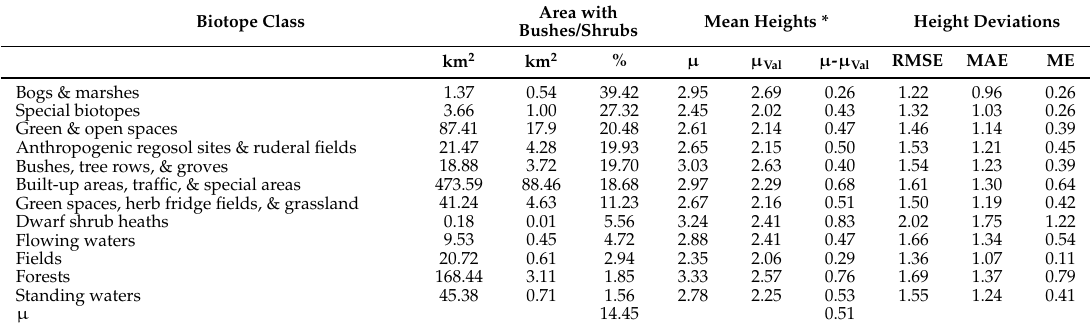
* The mean heights are weighted with the fractions of each biotope class layer on the pixels of the respective CHMs. Table 5. Area with bushes/shrubs (km 2 , %), Weighted mean vegetation heights ( µ ) and validation heights ( µ VAL ) and height deviations to validation heights (RMSE, MAE, and ME in meters) for bushes/shrubs in 12 biotope